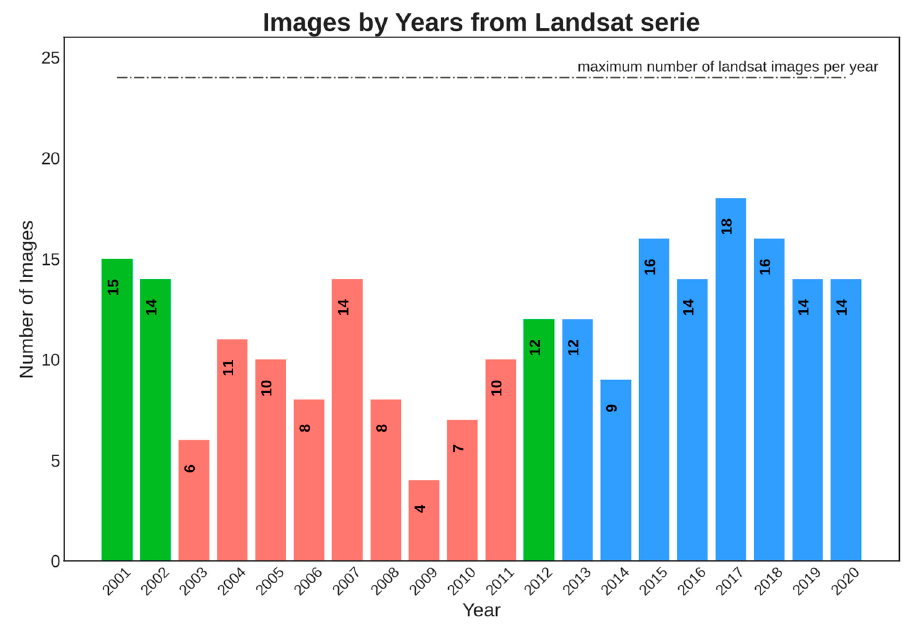
Figure 3. Distribution of images by sensor and year. Landsat 7 (ETM+) in green, Landsat 5 (TM) in orange, and Landsat 8 (OLI) in blue. Images with less than 70% of clouds were selected. We draw attention to the year 2009, with only 4 images available. The red dashed line represents the limit of the number of images per year (24 images).